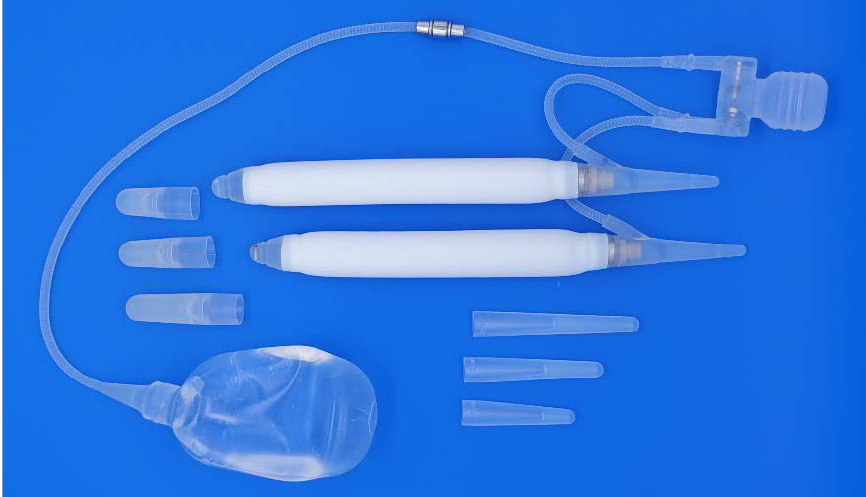
Figure 3. the ZSI475 for cis male implantation. Courtesy of Zephyr Surgical Implants, www.zephyr- surgical-implants.webflow.io (accessed on 16 November